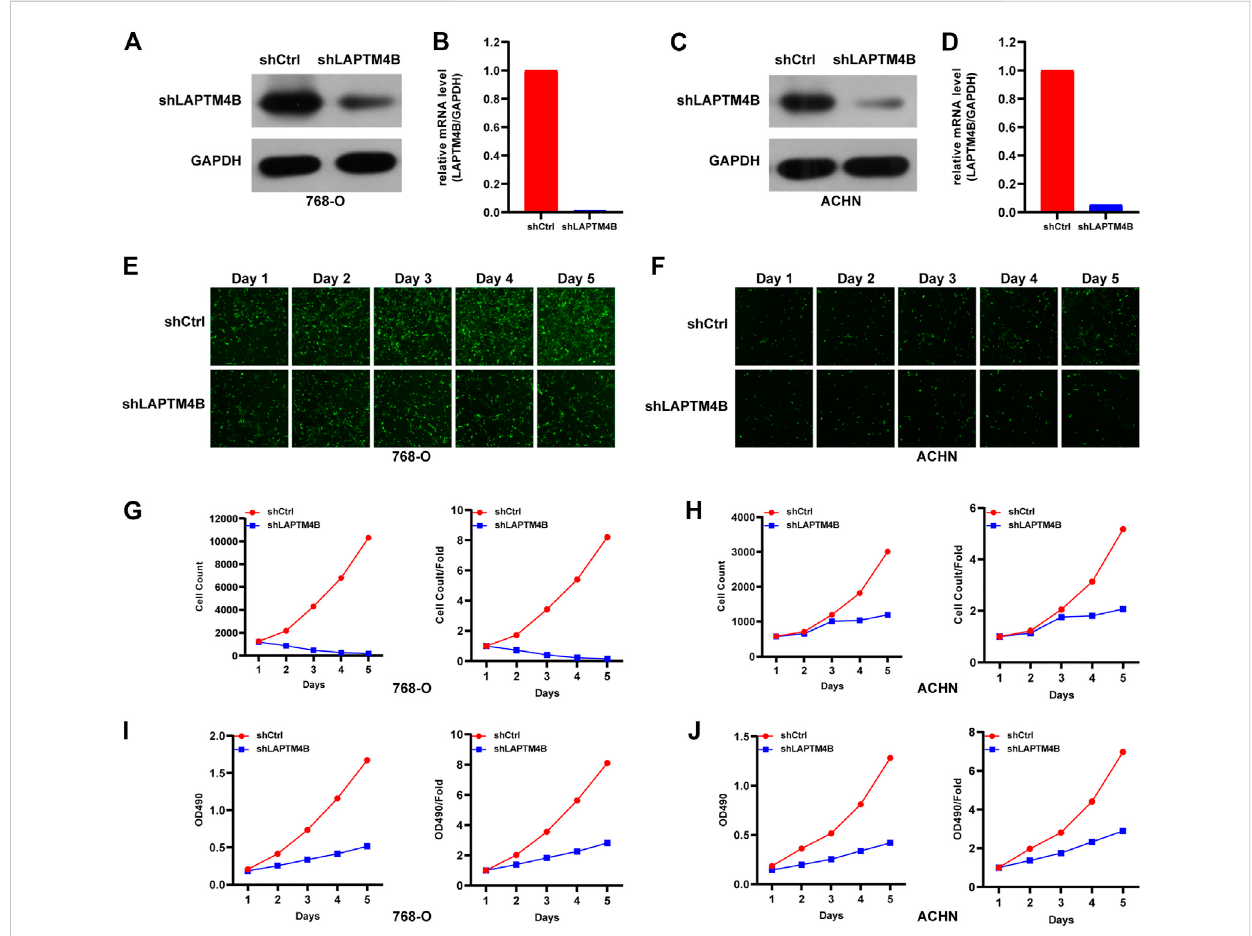
FIGURE 7 The role of LAPTM4B in ccRCC cell proliferation. (A,B) 786-O cells and (C,D) ACHN cells with LAPTM4B-shRNA lentivirus expressing either shCtrl andshLAPTM4B.GAPDHwasusedasthecontrol.AfterLAPTM4Bknockdown, (E,G) 786-Ocellsand (F,H) ACHNcellswithGFP fl uorescencedetectedby Celigo signi fi cantly decreased in 5 days. The numbers of ccRCC cells and proliferation rates were plotted for (I) 786-O cells and (J) ACHN